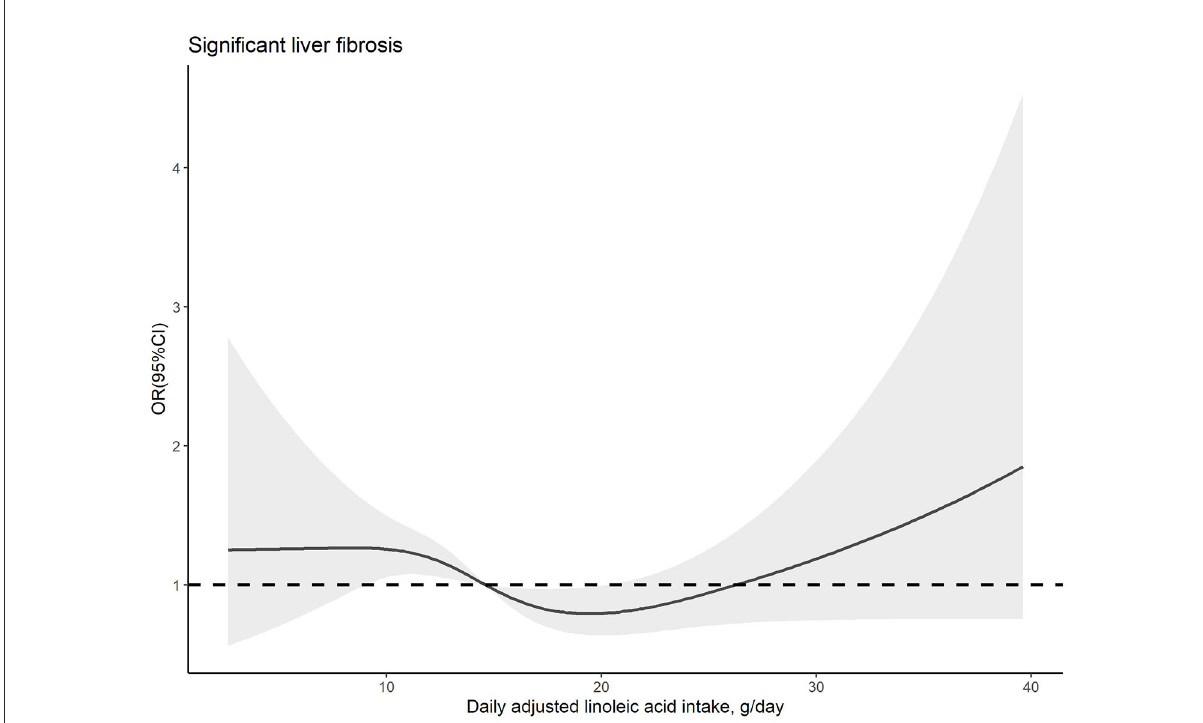
FIGURE3 Dose–response relationship between dietary linoleic acid intake and significant liver fibrosis. The solid line and shadow area represent the estimated odds ratios (ORs) and their corresponding 95% confidence intervals (CIs). The adjusted variables were the same as those in model 2, including age, sex, family income-to-poverty ratio, education level, marital status, ethnicity, platelet count, ALT, AST, GGT, ALP, albumin, total bilirubin, pre-hypertension, hypertension, diabetes, prediabetes, CVD, history of cancer, dyslipidemia, use of oral corticosteroid over 180